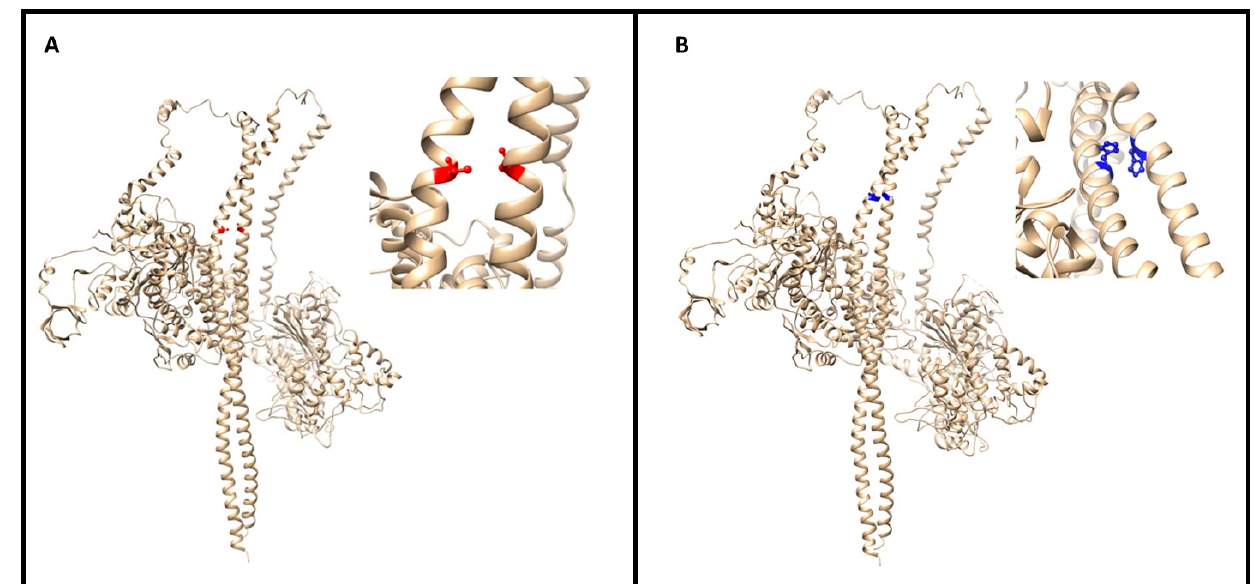
Figure 4. ( A ) The image (made with UCSF Chimera of the myosin dimer (PDB code 3dtp) with the mutation (M877T) colored in red; a close-up of the affected region is reported on the right. The mutations map at the interface between the two long α helices. ( B ) Global and closeup view of the MYH7 dimer (PDB code 3dtp) of the mutation site (R870H in blue). The involved residue positions map on the interaction interface between two α helices of the homodimer.